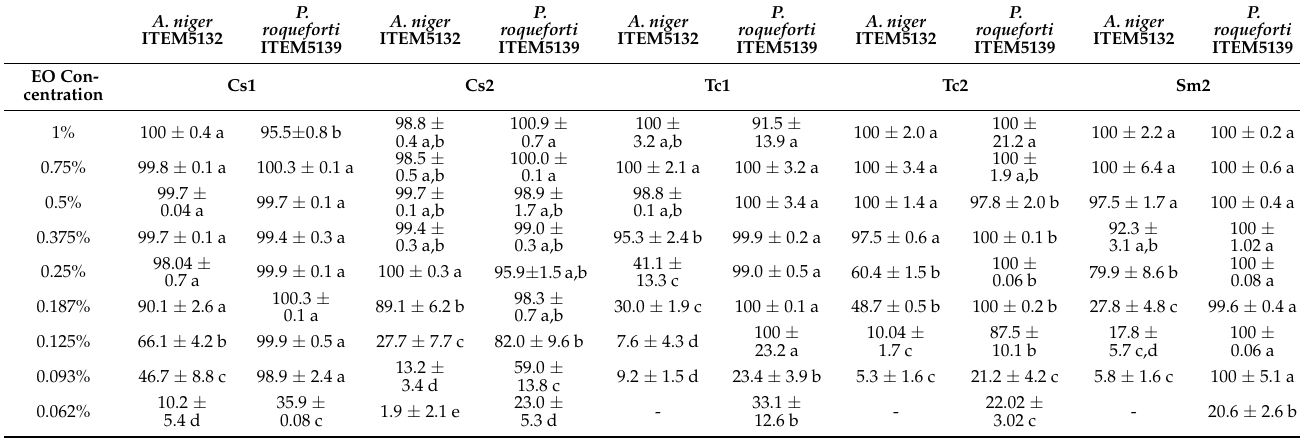
Table 5. Percent of inhibition (%) of fungal growth after 72 h incubation at 25 ◦ C by the EOs.